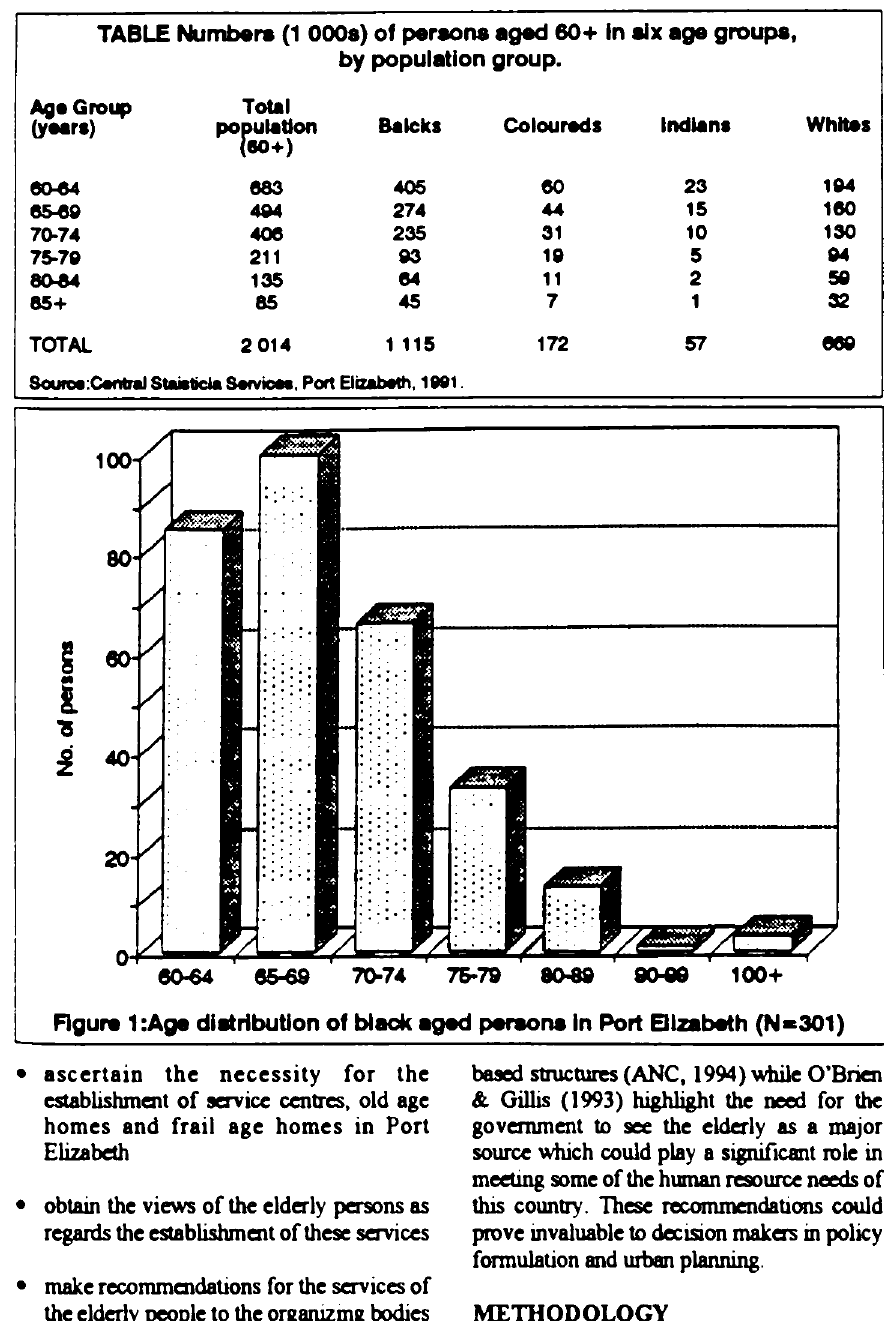
TABLE Numbers (1 000s) of persons agsd 60+ in six age groups, by population group.